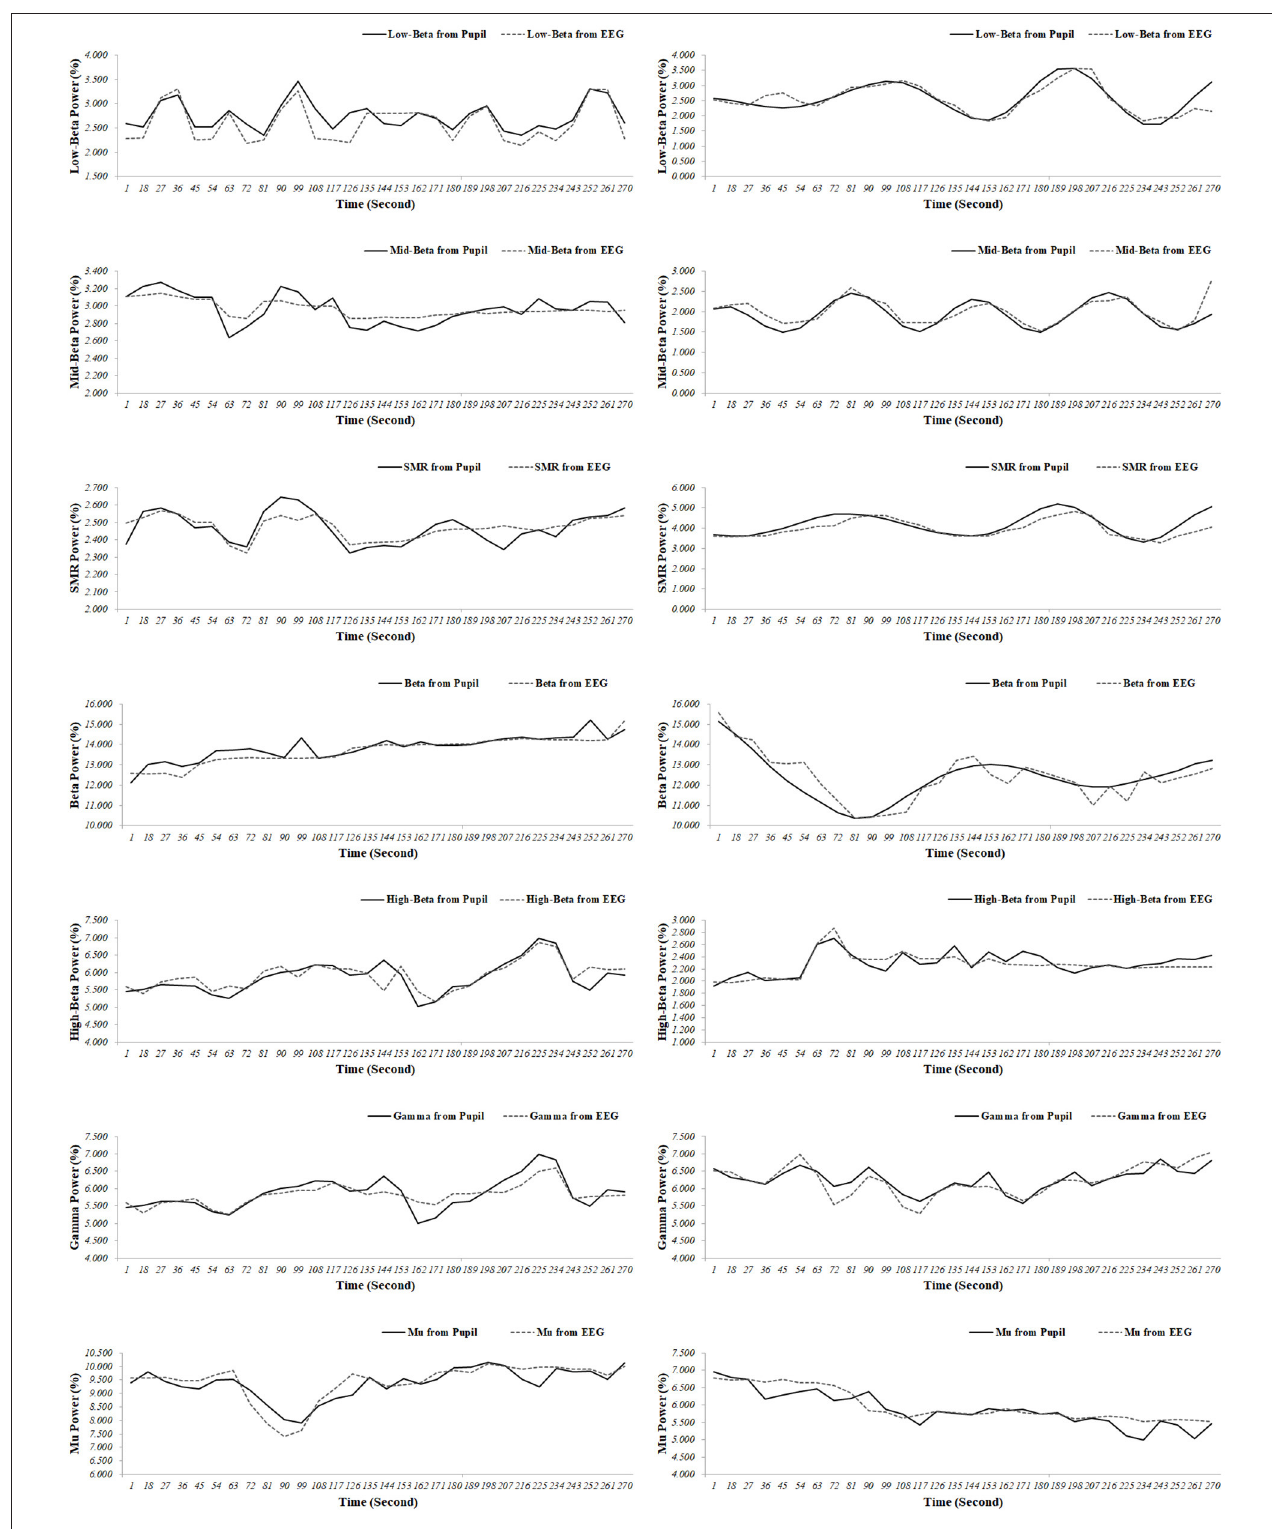
FIGURE 4 | Representative examples (participant 6 [left panel]; participant 42 [right panel]) of the electroencephalogram (EEG) spectral index from the pupil and EEG signals (low beta power in the FP1 region; mid beta power in the FP1 region; SMR power in the FP1 region; beta power in the F3 region; high beta power in the F8 region; gamma power in the P4 region; mu power in the C4